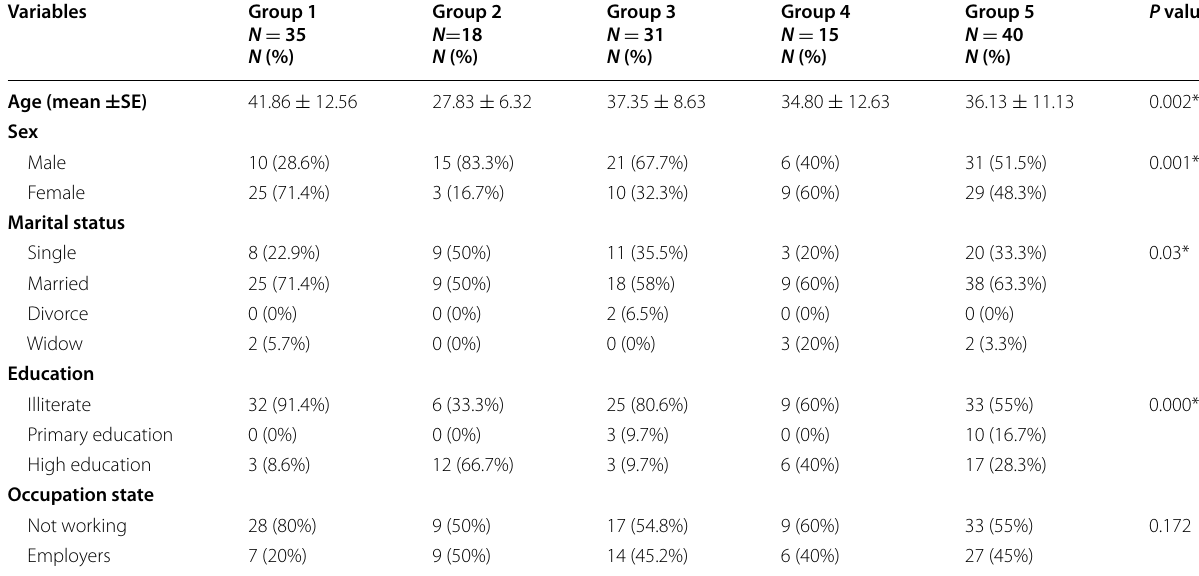
Table 1 Demographic data of studied groups